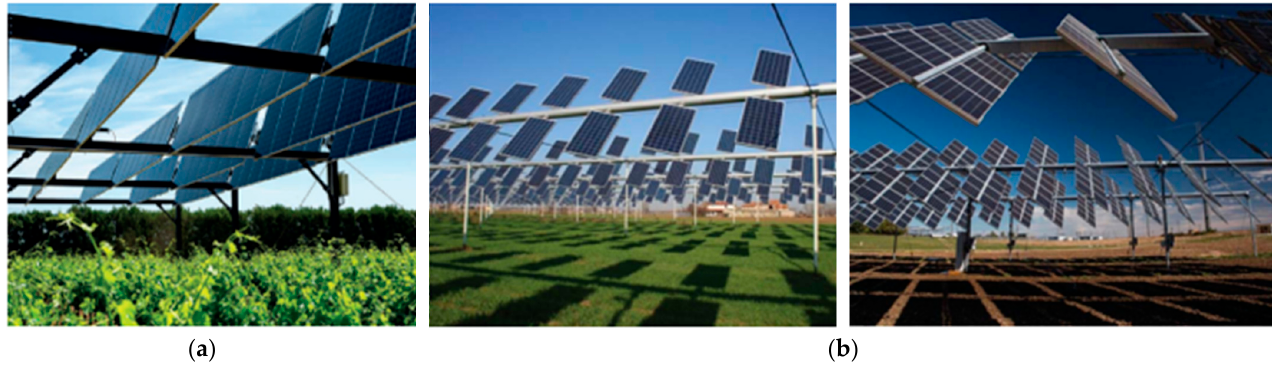
Figure 7. ( a ) Single-axis solar tracker module [44] and ( b ) dual-axis solar tracker module [60].